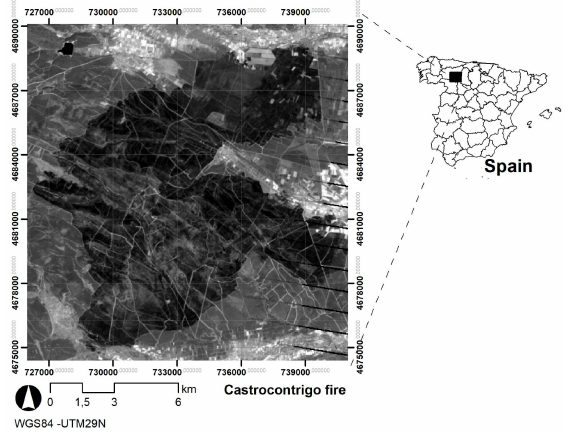
Figure 1. The location of the study